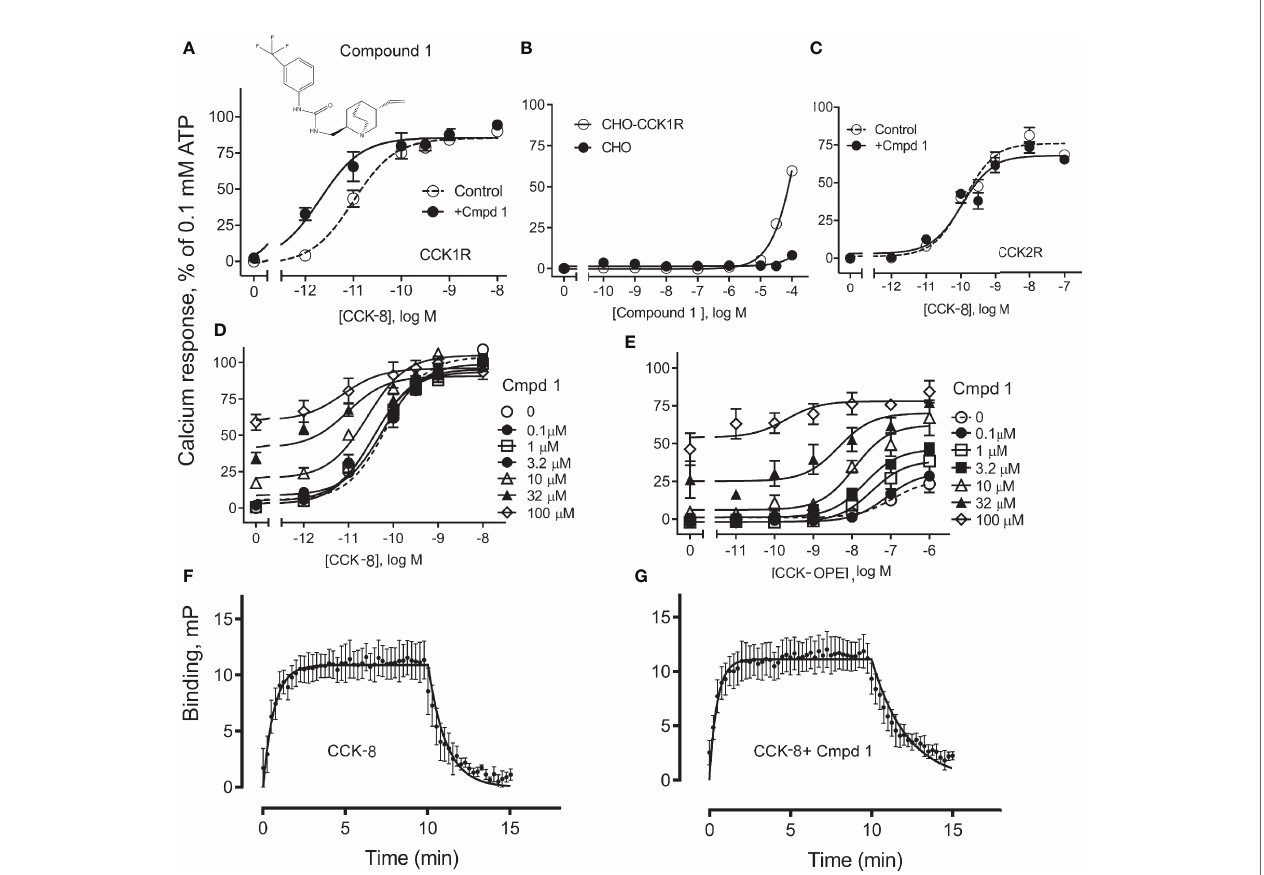
FIGURE 1 | Effect of Compound 1 on CCK-stimulated intracellular calcium responses at human CCK1R and CCK2R. Shown in (A) is the chemical structure of Compound 1 and the impact of 10 µM of this compound on intracellular calcium responses to CCK-8 in CHO-CCK1R cells that express high levels of this receptor. Compound 1 shifted the CCK-8 concentration – response curve to the left, acting as a PAM ( Table 1 ). (B) shows that Compound 1 did not directly stimulate an intracellular calcium response in the CHO-CCK1R cells when used in concentrations as high as 10 µM, and stimulated submaximal responses when used in 32 µM and 100 µM concentrations, while even these very high concentrations of Compound 1 did not elicit signi fi cant intracellular calcium responses at the non-receptor-bearing parental CHO cells. (C) shows that under similar conditions, Compound 1 had no modulatory effect on the ability of CCK-8 to stimulate intracellular calcium responses in CHO-CCK2R cells expressing the highly related type 2 CCK receptor ( Table 1 ). (D, E) illustrate the ability of various concentrations of Compound 1 to affect concentration – response curves for CCK-8 and CCK-OPE to stimulate intracellular calcium responses in CHO-CCK1R cells. These assays were also performed with very high concentrations of Compound 1 to allow calculation of allosteric constants. Under these conditions, PAM effects of this compound are obvious, with most marked shifts observed for the partial agonist, CCK-OPE. Values are expressed as percentages of the intracellular calcium responses to maximal stimulation achieved by 0.1 mM ATP and data points represent the means ± S.E.M. of data from a minimum of three independent experiments performed in duplicate. (F, G) show curves re fl ecting fl uorescent CCK binding association and dissociation in the absence (F) and presence (G) of 10 m M Compound 1. The off-rate of bound peptide is signi fi cantly slowed in the presence of Compound 1. Values re fl ect means ± S.E.M. of data from a minimum of three independent